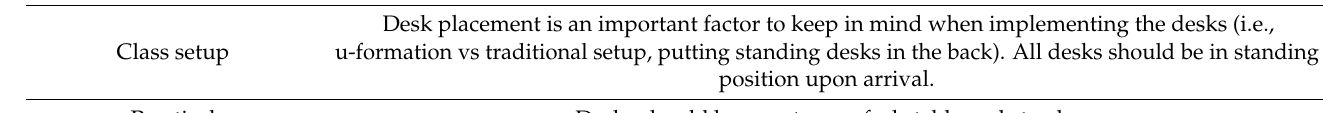
Table 4. Summary of the results for theme 4: What do you need to start using the sit to stand (StS) desk? Instruction form-dependent